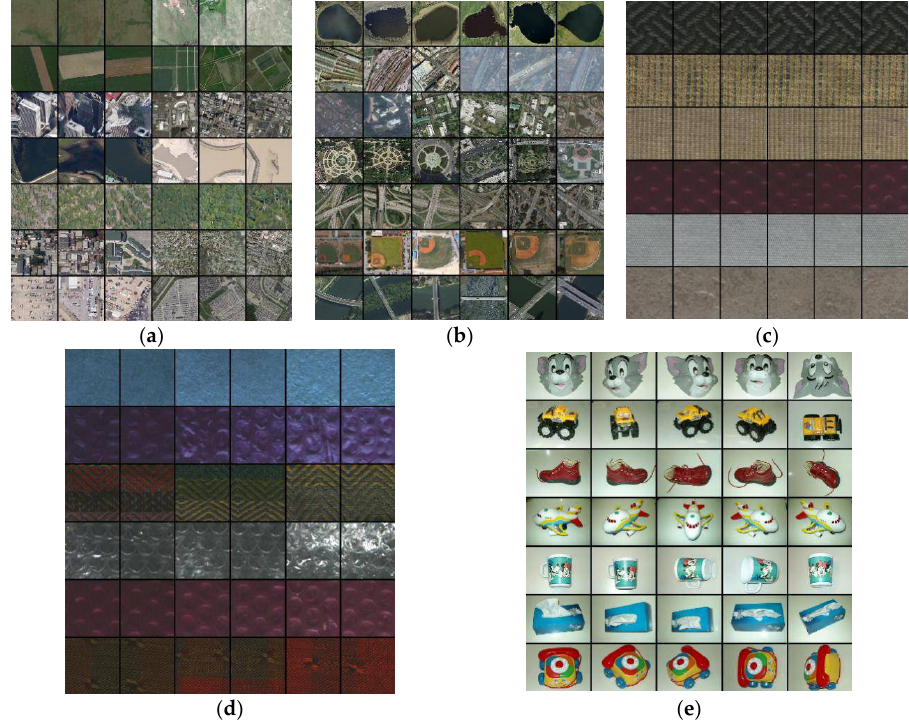
Figure 5. Some sample images from different databases: ( a ) RSSCN7; ( b ) AID; ( c ) Outex-00013; ( d ) Outex-00014; and ( e ) ETHZ-53.